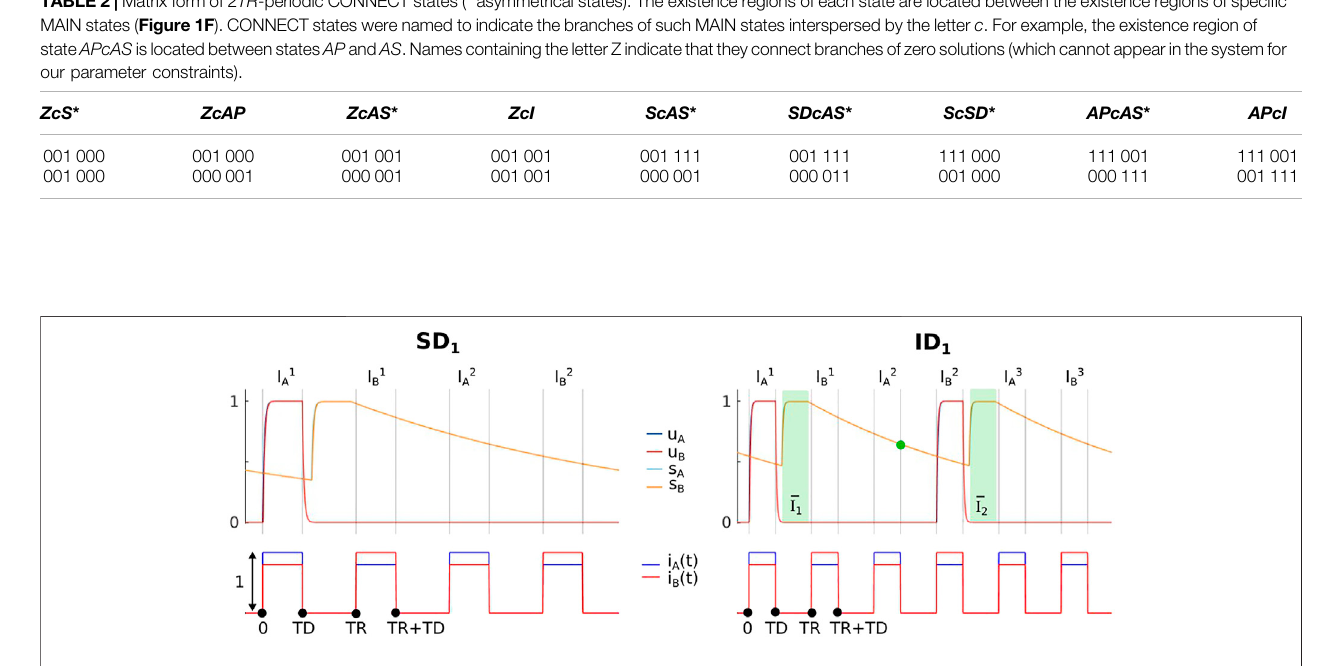
FIGURE2| Timehistoriesforstates SD 1 and ID 1 .Modelparametersinboth fi guresare a (cid:2) 0.6, b (cid:2) 2, d (cid:2) 0.8, θ (cid:2) 0.5, PR (cid:2) 17, TD (cid:2) 0.025, D (cid:2) 0.03, τ (cid:2) 0.001and τ (cid:2) 0.2. In addition, c (cid:2) 1.4 for the left panel and c (cid:2) 1.7 for the right i